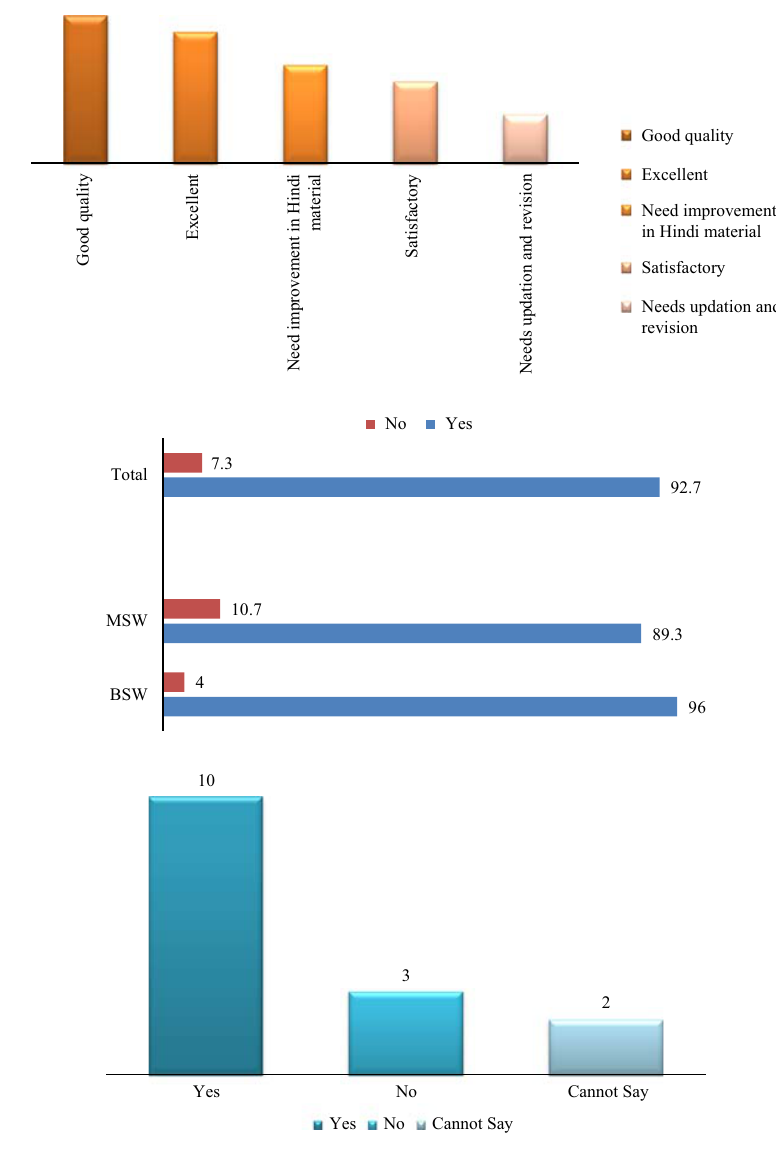
Figure 9. Views of academic